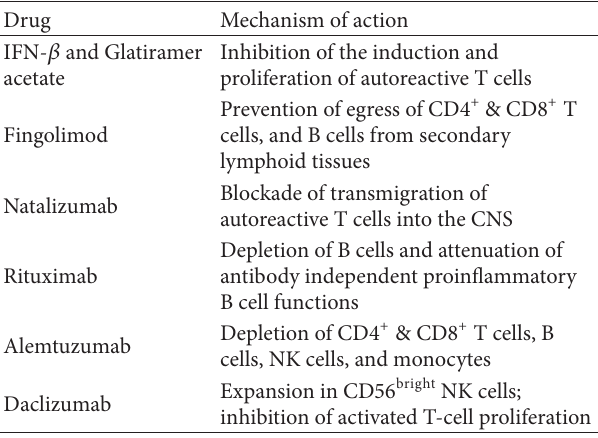
Table 1: Mechanisms of action of contemporary and emerging MS